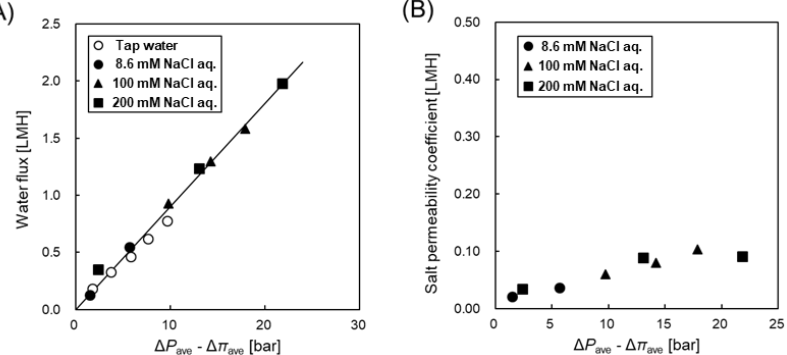
Figure 2. ( A ) Water flux and ( B ) salt permeability coefficient as a function of ∆ P ave - ∆ π ave with different salt concentration condition.